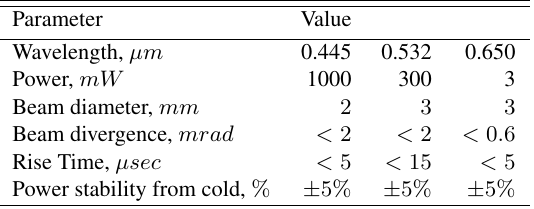
Table 3. Main characteristics of laser diode